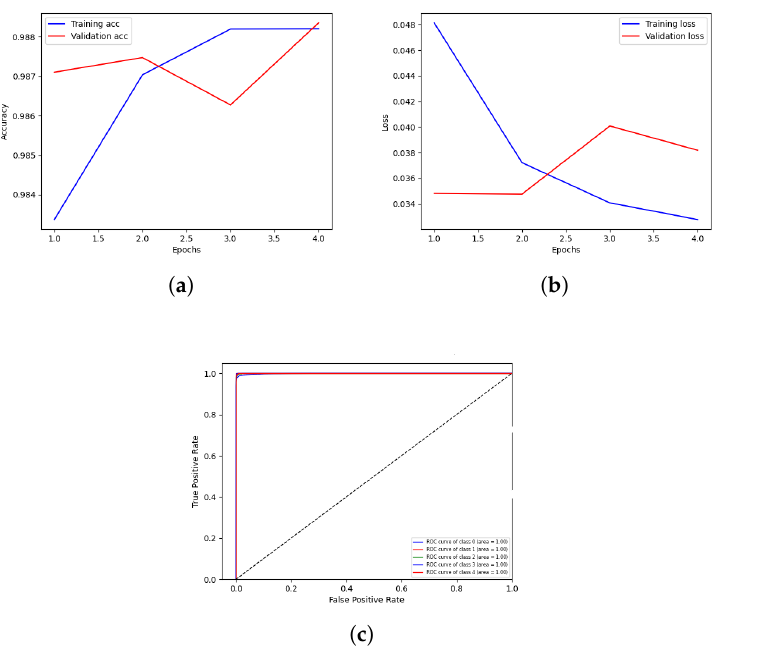
Figure 3. Graphical visualization of client 1 highest-scoring outcome. ( a ) Validation and training accuracy of round 3; ( b ) Validation and training loss of round 3; ( c ) Receiver Operation Characteristic score of round